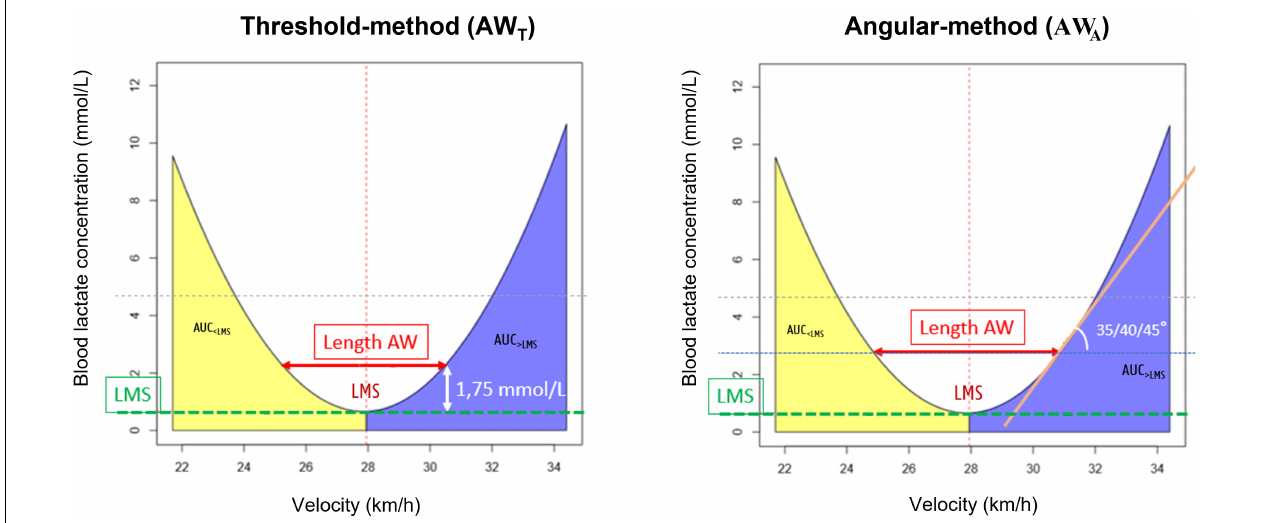
FIGURE 3 | Mathematical approaches to determine the aerobic window from the LMS-test. Left Panel: aerobic window calculation, using the threshold method; Right Panel: aerobic window calculation, using the angular method. AW, aerobic window; LMS, lactate minimum speed; AUC < LMS , area under the curve at the left side of the LMS; AUC > LMS , area under the curve at the right side of the LMS.